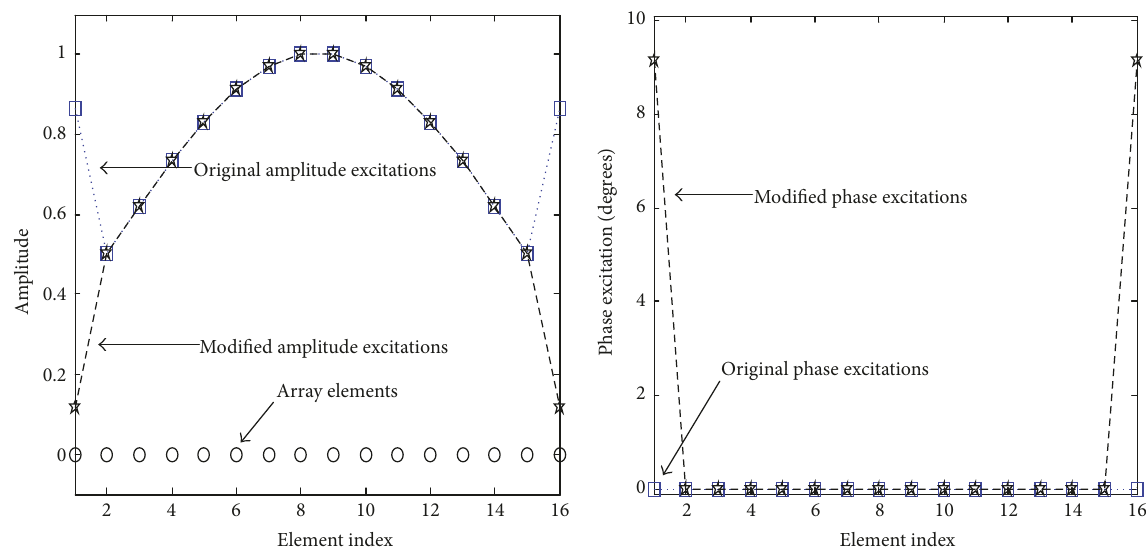
Figure 3: Amplitude and phase distributions of the original Dolph-Chebyshev array and the proposed arrays for 𝑁 = 16 and 𝑑 = 𝜆/2 .